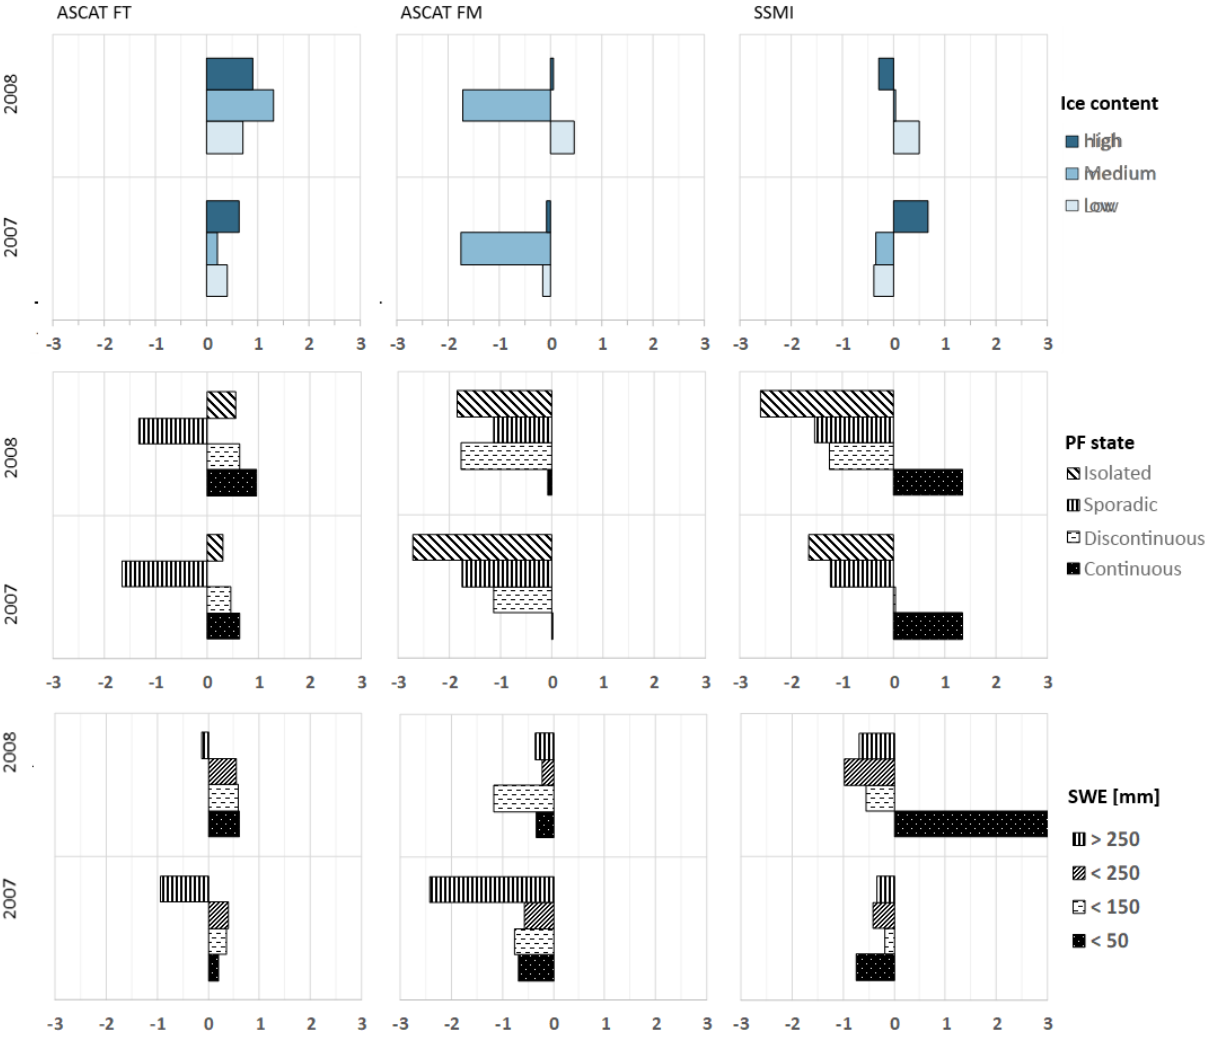
Figure 11. Difference between modelled MAGT c and in situ MAGT c (coldest sensor) by permafrost zone and ice content (source is Brown et al., 1997), and snow water equivalent (SWE; source is GlobSnow) categories in 2007/2008 and 2008/2009. FT – days identified as frozen without melting snow are used; FM – days with melting snow are considered to be frozen ground in ASCAT. Note that the class with a SWE < 50mm contains only two samples in the case of SSM/I for 2008 (“Tiksi stone ridge” and “Dionisiy-111(2)” in the northern Russian Far